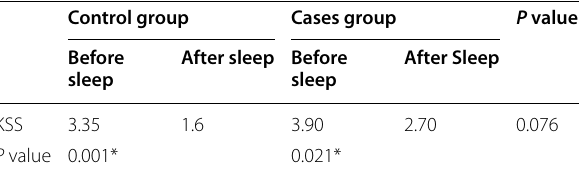
Table 1 KSS comparison from before to after sleep in both groups